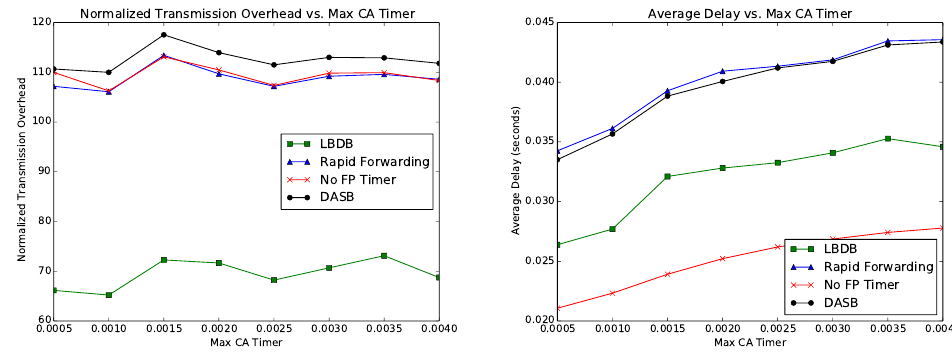
Figure 12. Impact of Max CA